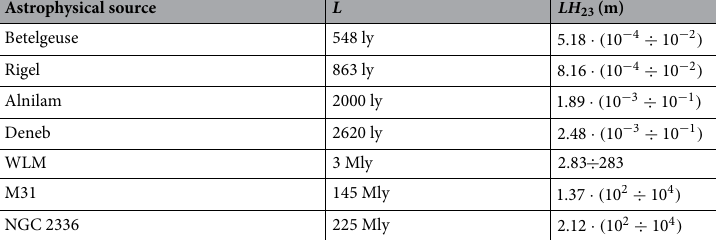
20 27 22 32 and 10 − , respectively. The distance L has been 6 15 ly and 1 ly = 9.4607 · 10